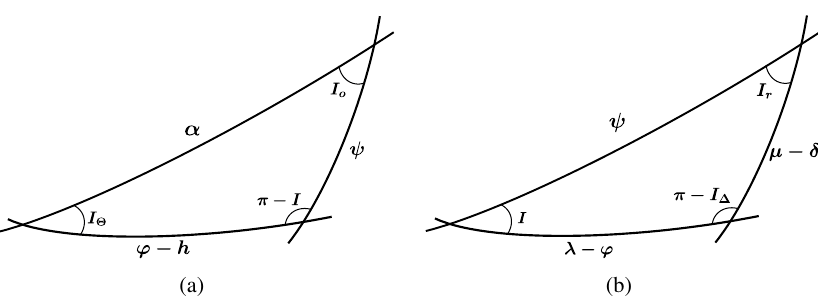
Fig. 11 Spherical triangles involved in the problem. α is the angle between the two nodes of the orbital plane. (a) Triangle formed by the orbital angular momentum plane, the total angular momentum plane and the reference plane. (b) Triangle formed by the rotational angular momentum plane, the total angular momentum plane and the reference